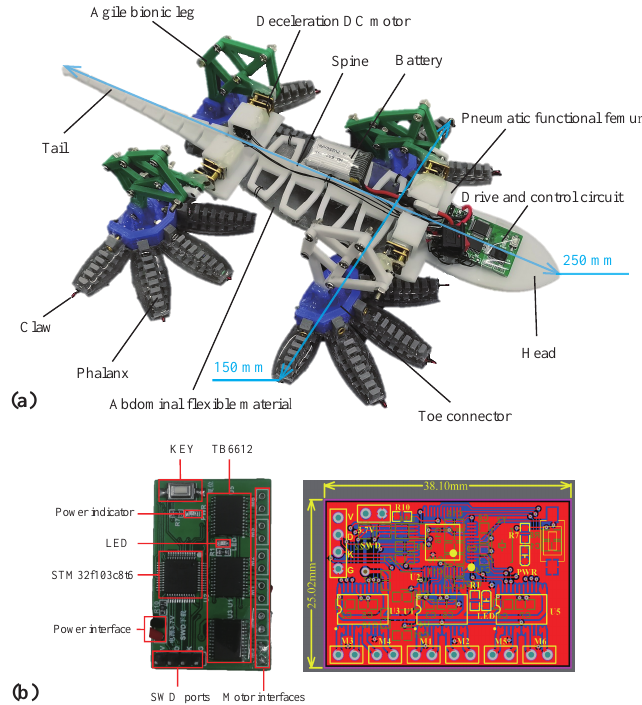
Figure 15. ( a ) Photograph of the anole lizard-like climbing robot and ( b ) drive and control circuit.